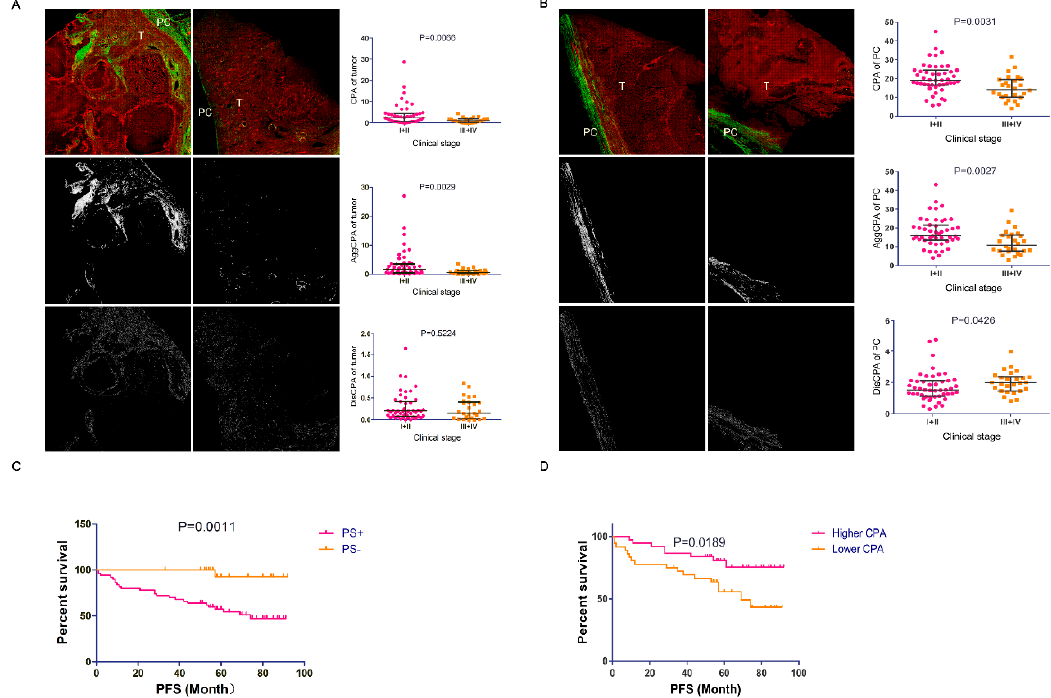
Figure 2. Quantification and significance of fibrosis. Representative images of second harmonic generation (SHG), AggCPA and DisCPA in tumors ( A ) and PCs ( B ). ( C ) Kaplan-Meier curves of progression-free survival (PFS) of patients with PC + and PC- status. ( D ) Kaplan-Meier curves of PFS of patients with higher or lower PC CPA status (T: tumor; PC: pseudo-capsule; CPA: collagen proportional area; Dis (DisCPA): percentage of distributed collagen proportional area; Agg (AggCPA): percentage of aggregated collagen proportional area).